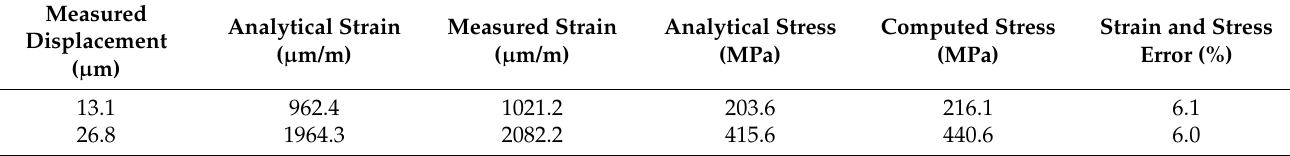
Table 4. Experimental and analytical strain and stress comparison of UHCF S690 specimen.